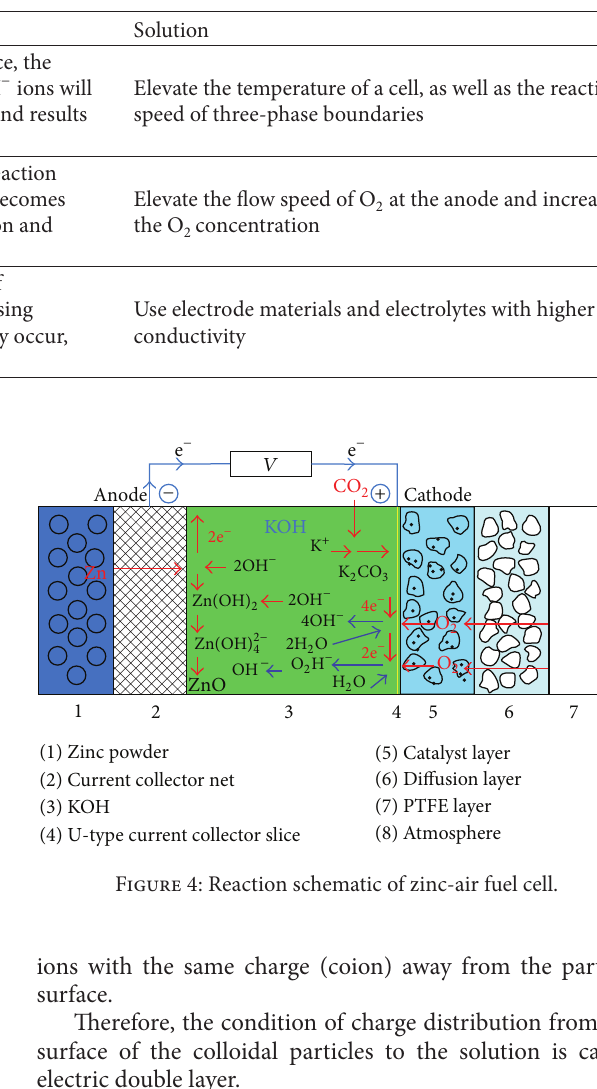
Table 1: Causes of three types of overvoltage and their solutions.